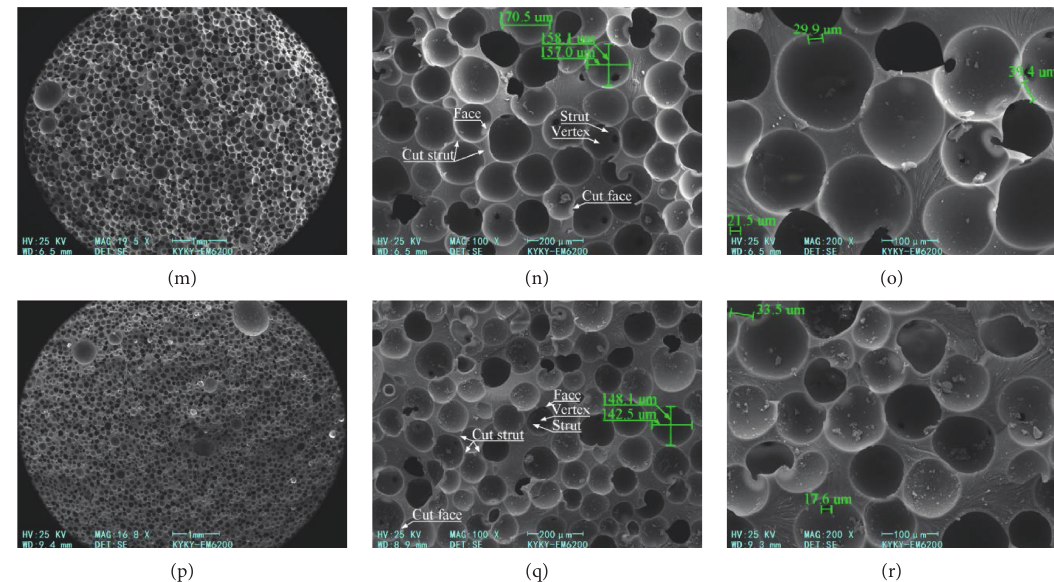
Figure 4: Microstructure of polymers at different densities. (a) 0.11g/cm 3 ; (b) detail of (a); (c) detail of (b); (d) 0.25g/cm 3 ; (e) detail of (d); (f) detail of (e); (g) 0.31 g/cm 3 ; (h) detail of (g); (i) detail of (h); (j) 0.40g/cm 3 ; (k) detail of (j); (l) detail of (k); (m) 0.51g/cm 3 ; (n) detail of (m); (o) detail of (n); (p) 0.56g/cm 3 ; (q) detail of (p); (r) detail of